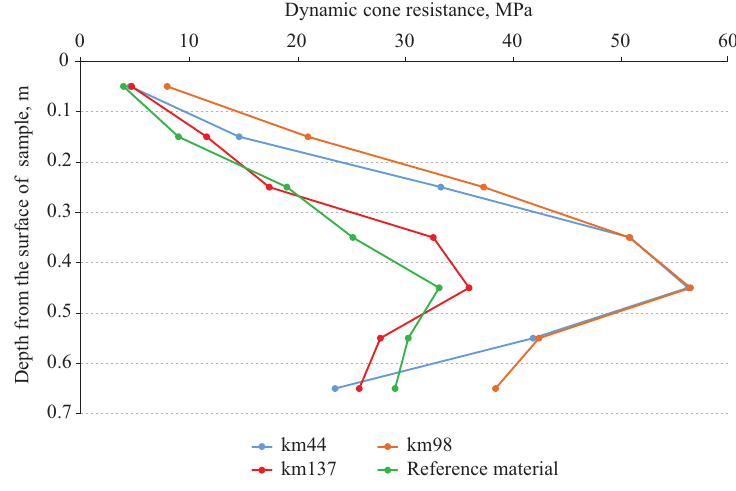
Figure 6. Dynamic cone resistance measured with oven-dry